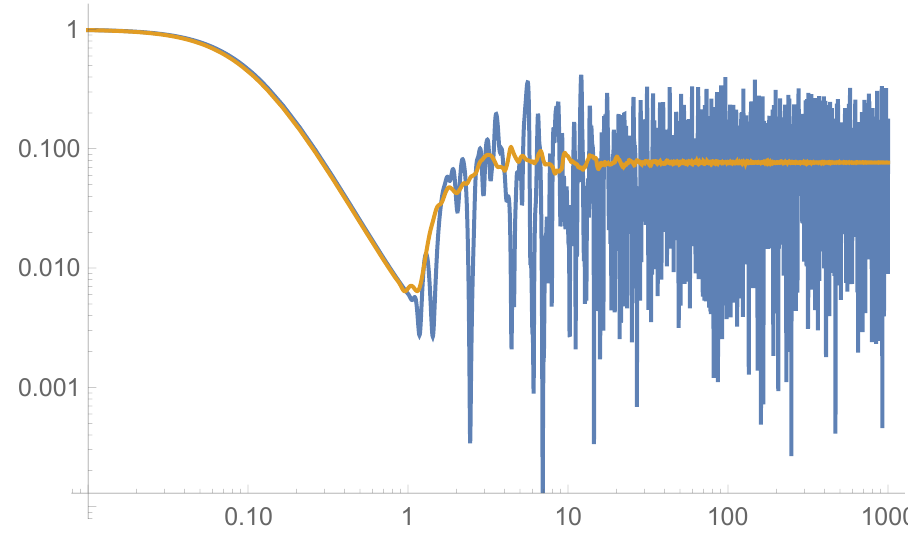
Figure 9 . Spectral form factor (and its progressive time average) for (cid:12) = 0 : 1 and 20000